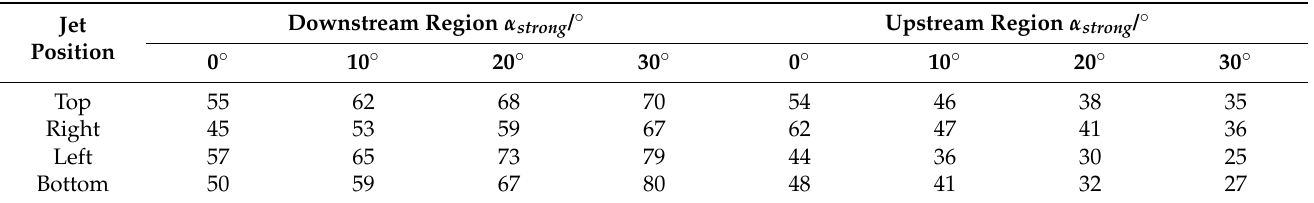
right jet, left jet and bottom